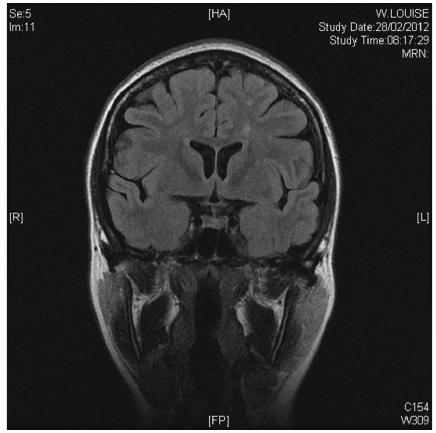
Figure 3: Coronal view showing periventricular lesions supporting a clinical diagnosis of demyelination in the clinical context and knowledge of the